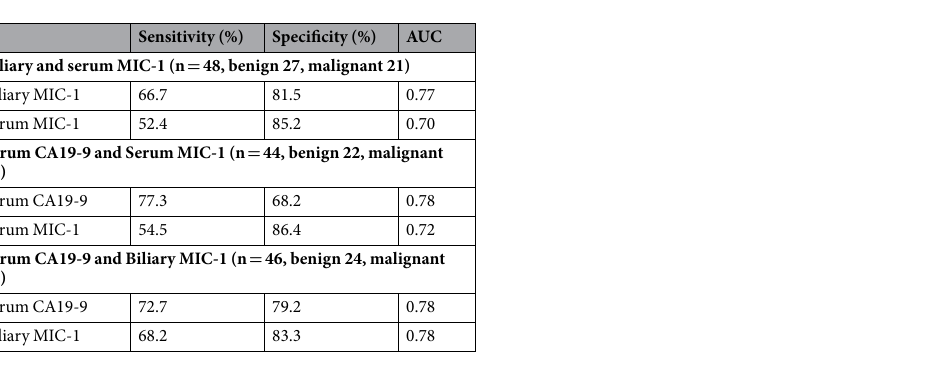
Table 2. Comparison of the different markers in each patient. AUC , area under the curve; MIC-1 , macrophage inhibitory cytokine-1.